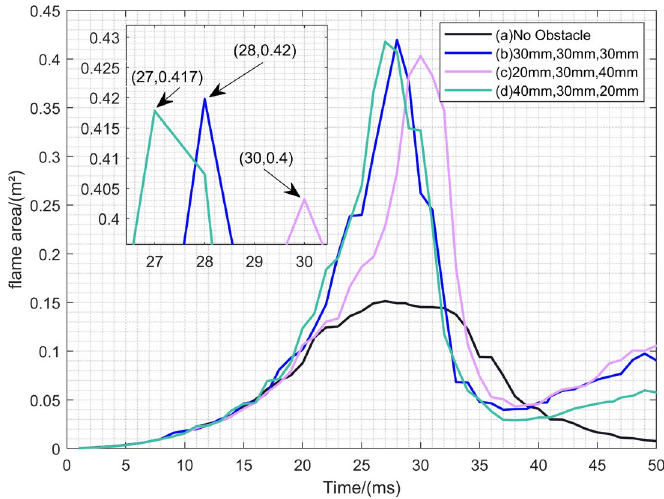
Figure 9. Comparison of area of flame for four working conditions.